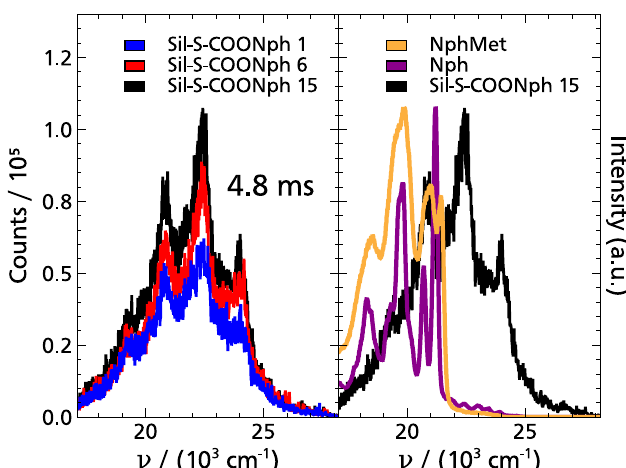
Figure 8. TSD results on functionalized spherical silica in 1-propanol at T = 90K. ( Left ) The comparison of phosphorescence spectra of the different functionalizations at t = 4.8ms reveals that the measured intensity increases with increasing distance between different NphMet groups. ( Right ) Comparison of the phosphorescence spectra of Sil-S-COONph 15 with the spectra of pure Nph, respectively, NphMet dissolved in 1-propanol. The latter spectra were recorded at t = 200ms. The maximum intensity of each spectrum was normalized. It can be observed that although all spectra look similar in their peak structure, the spectra of the functionalized samples are significantly shifted in energy ( ∼ 2600cm − 1